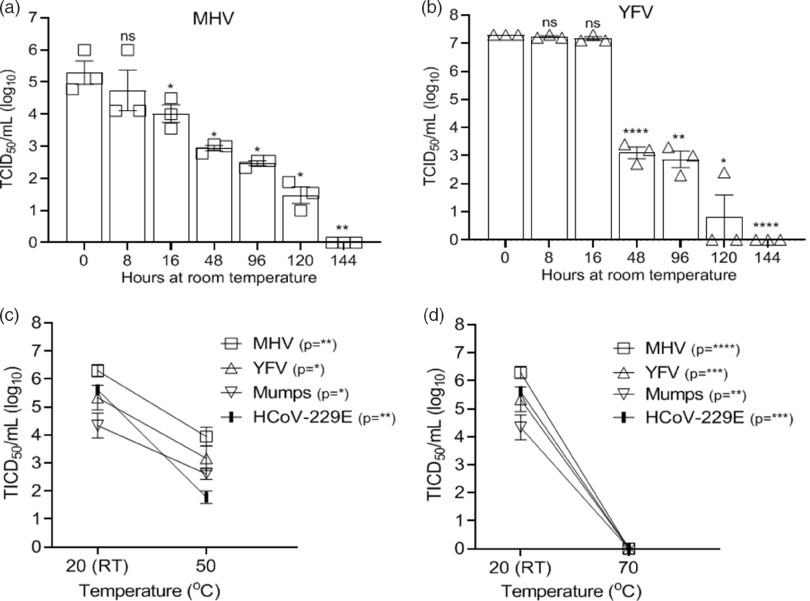
Effectiveness of virus thermal inactivation. Recovery of virus over time from 3D-printed mask material incubated at room temperature (RT, 20°C) for (A) MHV and (B) YFV. Recovery of virus from 3D material after thermal inactivation for 30 minutes at (C) 50°C or (D) 70°C. Virus incubated at 20°C (RT) acted as the control. Virus titer was completed as described in the Methods section in the cell type indicated in Table 1. Significance was determined using the Student t test. *P < .05; **P< .01; ***P < .001; ****P < .0001; ns, not significant. Error bars represent standard error of the mean (SEM) of triplicate experiments.